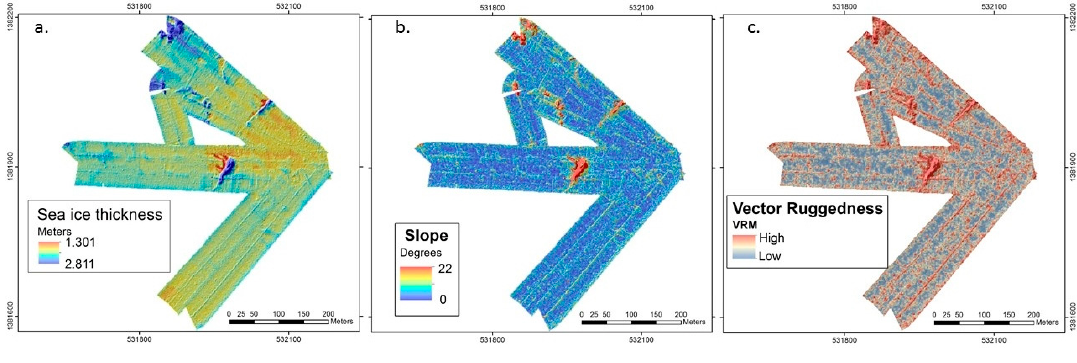
Figure 6. Spatial metrics that were derived from the 1 m bathymetric grid; ( a ) sea ice thickness; ( b ) slope [35]; ( c ) vector ruggedness measure (VRM).